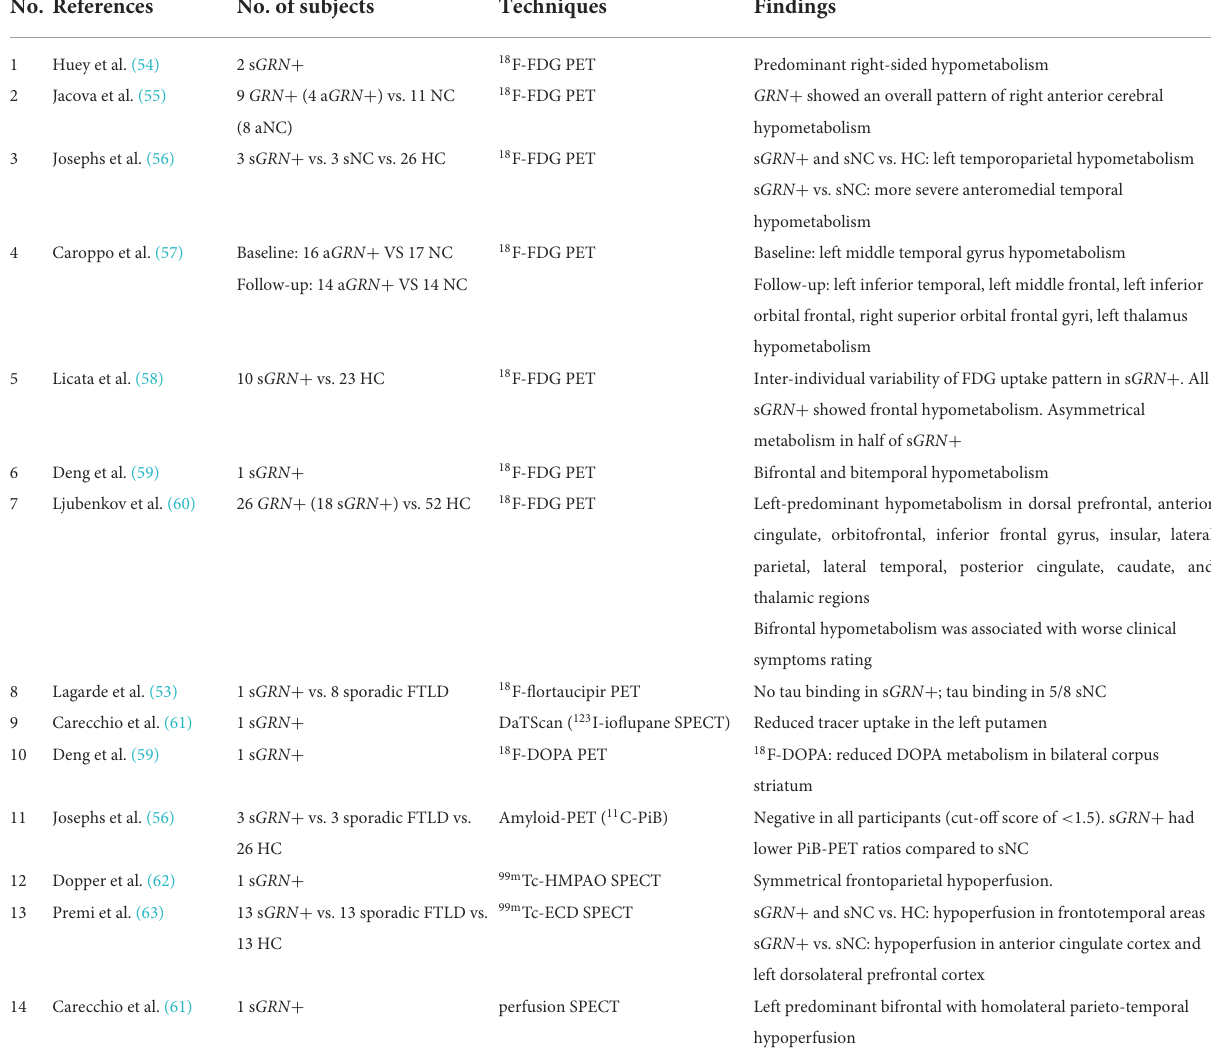
TABLE 2 Studies investigated asymptomatic/symptomatic GRN carriers.